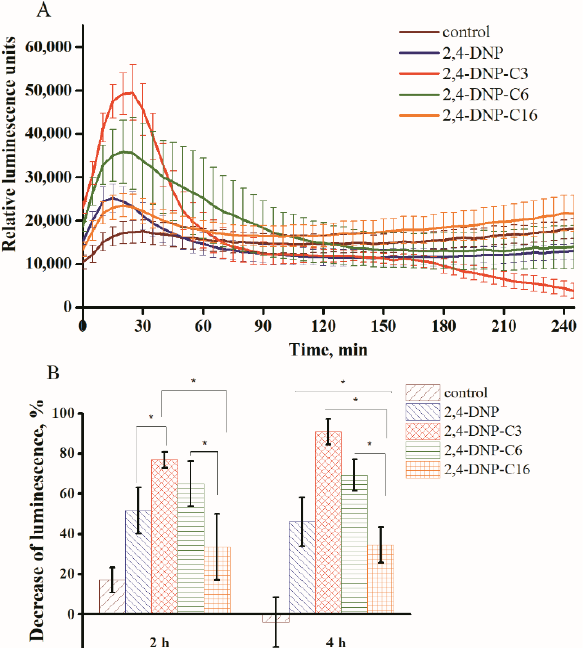
Figure 2. Luciferin–luciferase coupled assay using 4T1-Luc cell line in RPMI 1640 (10% FBS) at 37 ◦ C. Figure 2. Luciferin – luciferase coupled assay using 4T1-Luc cell line in RPMI 1640 (10% FBS) at 37 The total luciferin concentration was 150 µ g/mL; 2,4-DNP (compound 1 ), 2,4-DNP-C16 (compound °C. The total luciferin concentration was 150 µg/mL; 2,4-DNP (compound 1 ), 2,4-DNP-C16 2 ), 2,4-DNP-C6 (compound 3 ), 2,4-DNP-C3 (compound 4 ) concentrations were 200 µ M per well. Samples were dissolved in DMSO. The final concentration of DMSO was 1% per well. The samples with untreated cells (only luciferin addition) were set as control. ( A ) Kinetic profiles of the reaction without (control) and after addition of 2,4-DNP, 2,4-DNP-C3, 2,4-DNP-C6, 2,4-DNP-C16. Data are presented as mean ± StD ( n = 12–18). ( B ) Decrease in luminescence signal from a maximum at the beginning of the reaction (30 min point) during 2 h and 4 h. Data are presented as mean ± StD ( n = 12–18), * p <